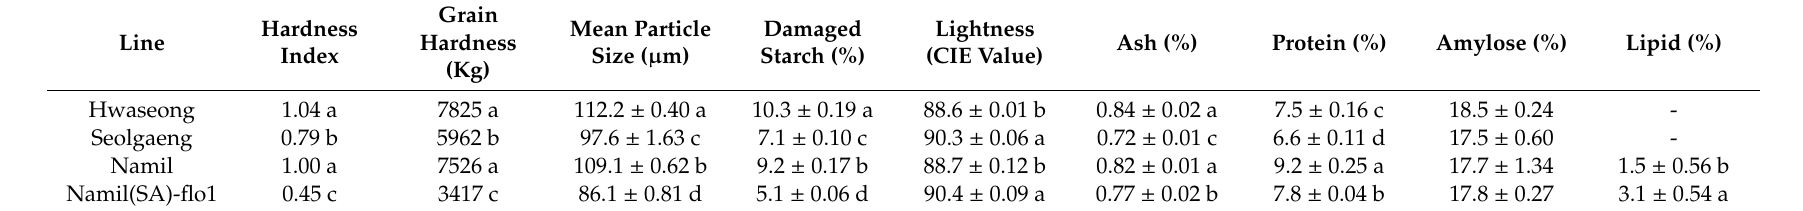
Table 2. Physicochemical properties of grains and rice